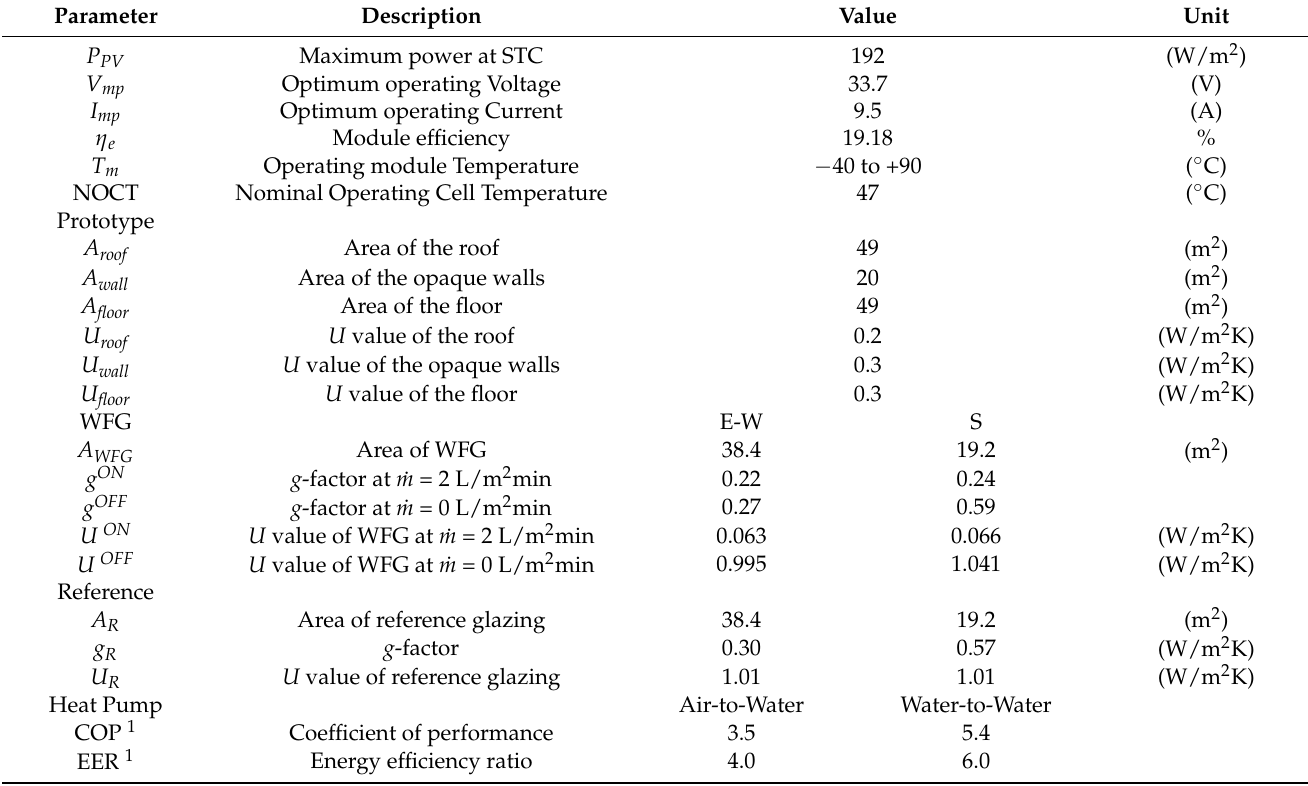
Table 1. Description of the energy management